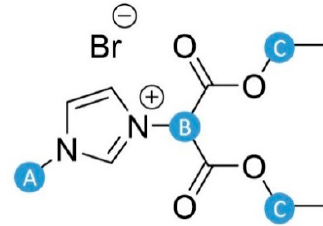
Figure 6. Carbon atoms susceptible to a nucleophilic attack by bromide anion in pure